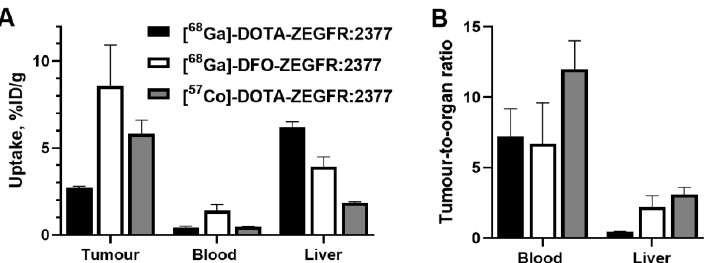
Figure 13. Uptake ( A ) and tumor-to-organ ratios ( B ) for ZEGFR:2377 affibody molecules labeled using [ 68 Ga]-DOTA-, [ 68 Ga]-DFO-, and [ 57 Co]-DOTA-radionuclide/chelator combinations in mice bearing A431 xenografts 3 h after injection. Data from [99] and [101].